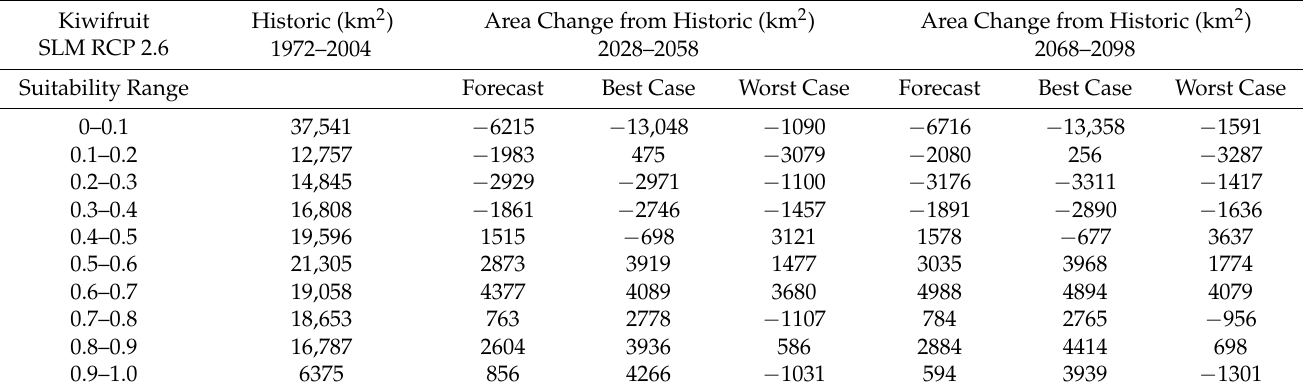
Table A4. Kiwifruit: land area in the historic period falling into different cultivation suitability ranges, forecast change for the mid- and late-century under RCP 2.6 and best and worst cases.